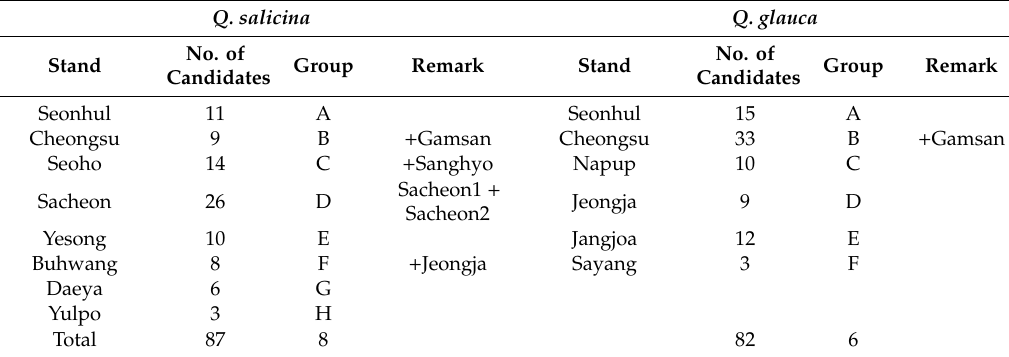
Table 3. The adjusted groups and the number of candidate trees selected in each group in Quercus salicina and Q. glauca